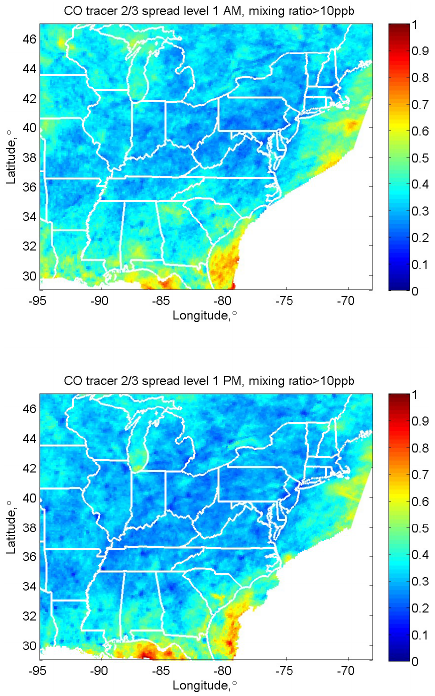
Figure 9: Mean ensemble spread of tracer mixing ratio at level 1 (0-100 m AGL). The averages 560 Figure 9. Mean ensemble spread of tracer mixing ratio at level 1 are taken over all 49 days and hours 0400-0600 LST (AM, top) and 1300-1500 LST (PM, bottom). 561 (0–100ma.g.l.). The averages are taken over all 49 days and hours The spread is normalized by the mean mixing ratio at each point. Points with small mean values 562 04:00–06:00LST (AM, top) and 13:00–15:00LST (PM, bottom). The spread is normalized by the mean mixing ratio at each point. (<10 ppbv) are masked out. 563 Points with small mean values ( < 10ppbv) are masked out.